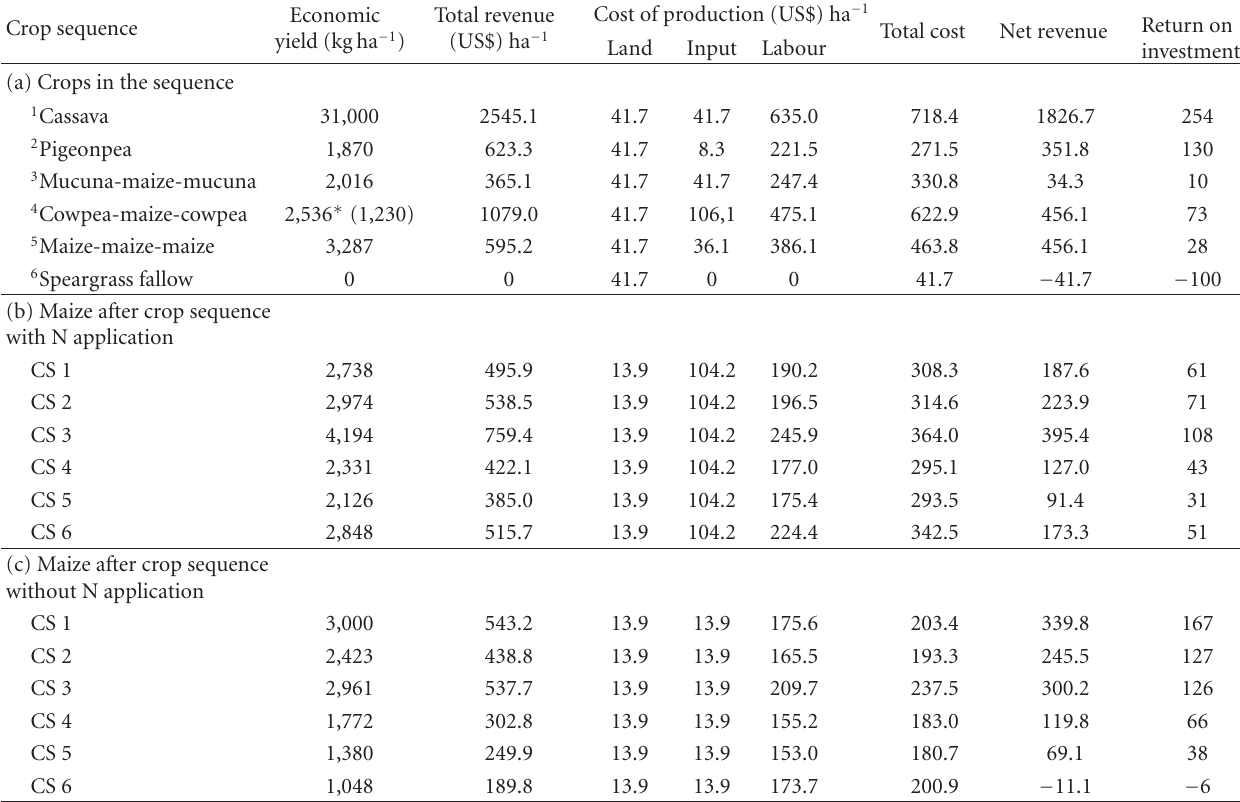
Table 4: Estimated costs of production, gross revenue, and returns on investment of (a) various crop sequences (b) maize grown after the sequences with N application to the maize and (c) maize grown after the sequences without N application to the maize. Crop sequence